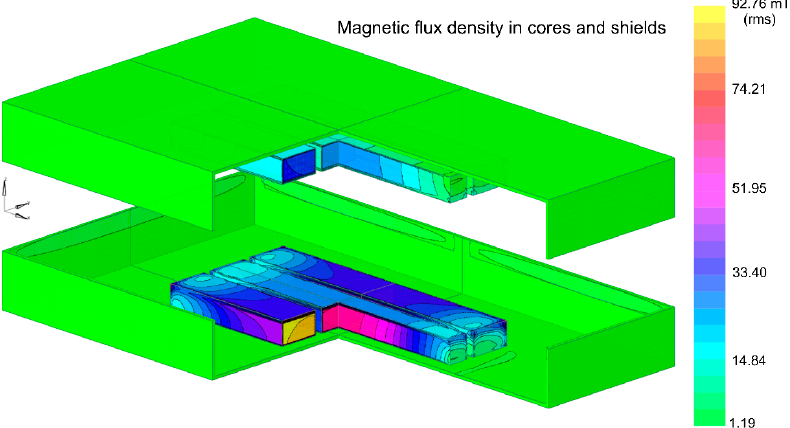
Figure 5. Magnetic flux density distribution in the ferrite cores and in the shields when only the lower winding is fed. The maxima occur in the central section of the outer lines of the ferrite core.